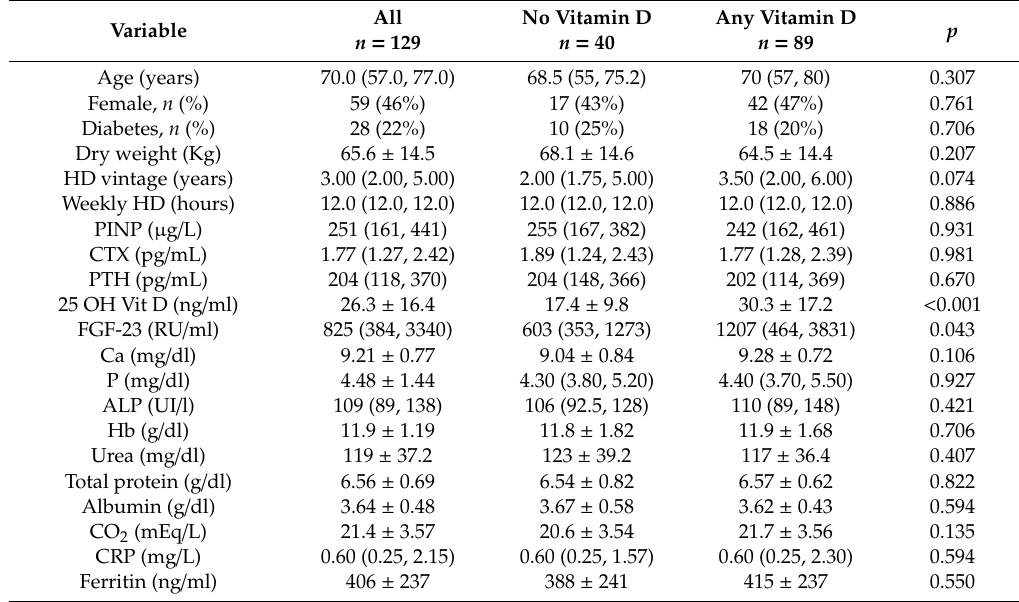
Table 1. Demographic, biochemical and clinical characteristics of the study population.